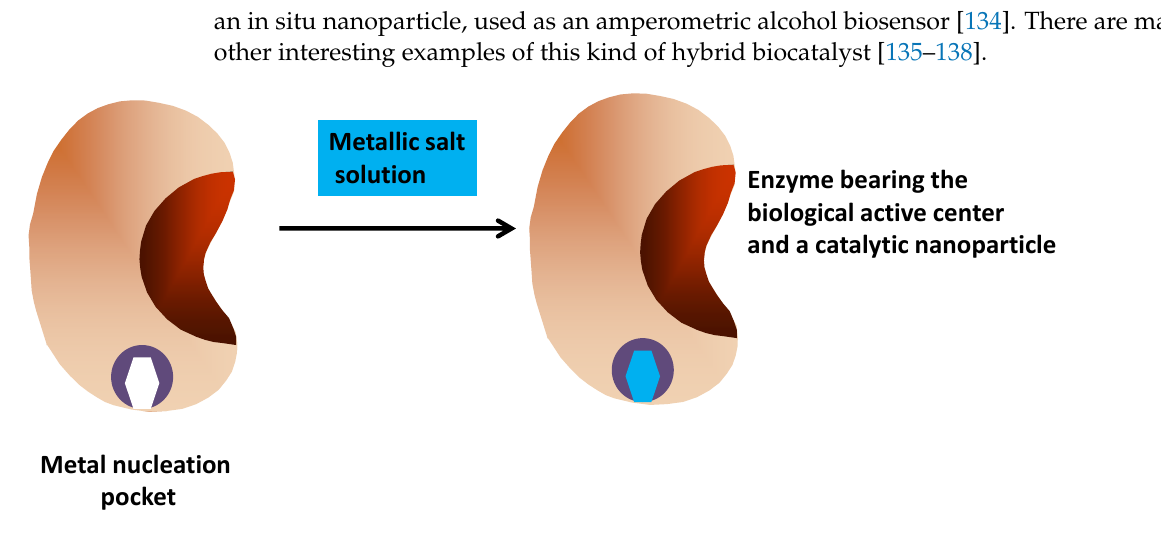
Figure 3. Preparation of an enzyme bearing its biological center and a nanoparticle.